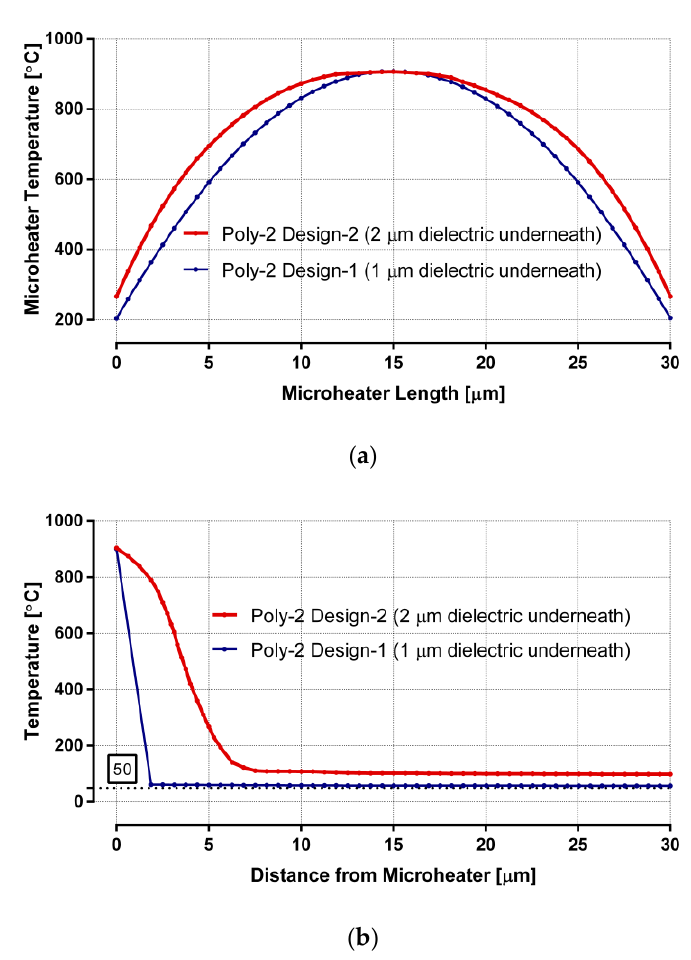
Figure 5. Thermal analysis of partially suspended poly-2 designs: ( a ) microheater temperature along its length; ( b ) temperature distribution from the center of the heater to the surrounding surface.